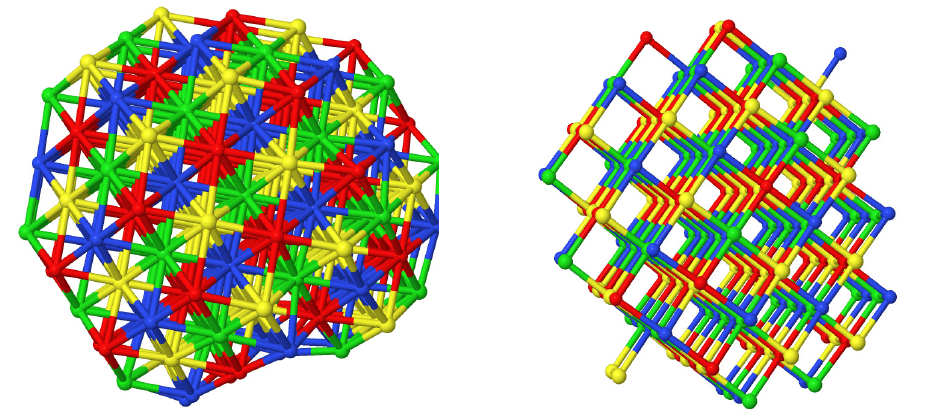
Figure 3: Generic lattice structures found in the non-Abelian phase. Left: A sample of fcc lattice from a simulation with 5000 instantons at α = 1 and β = 0.5. Right: A sample of simple cubic lattice from a simulation with 6000 instantons at α = 0.5 and β = −